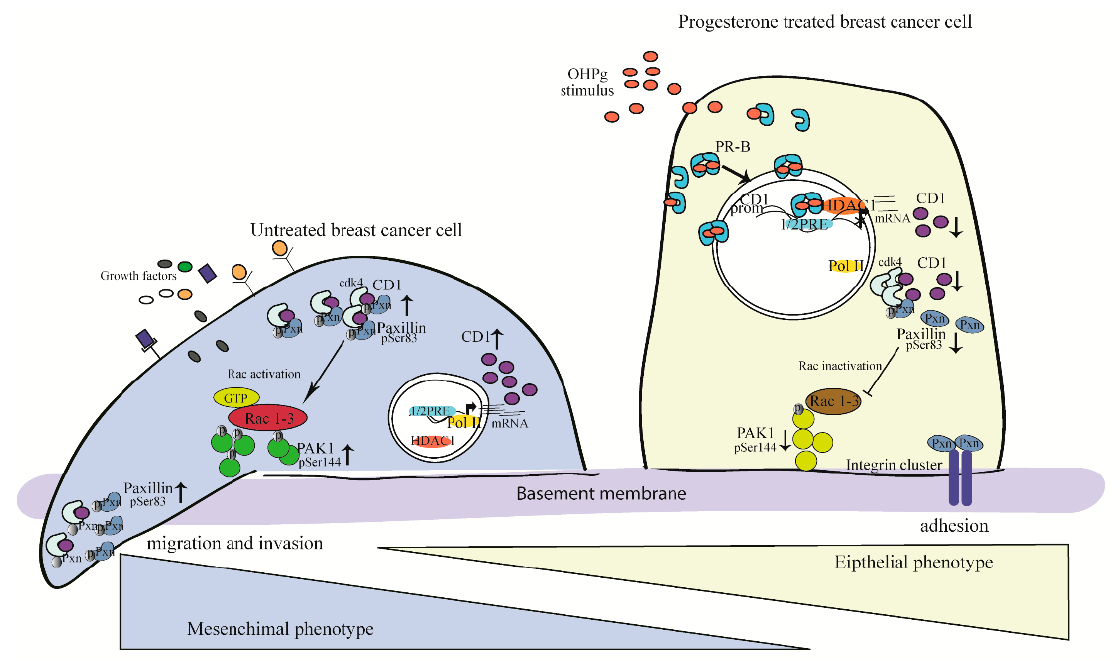
Figure 7. Proposed model for OHPg / PR-B-induced mesenchymal-epithelial transition in breast cancer cells. See text for details.